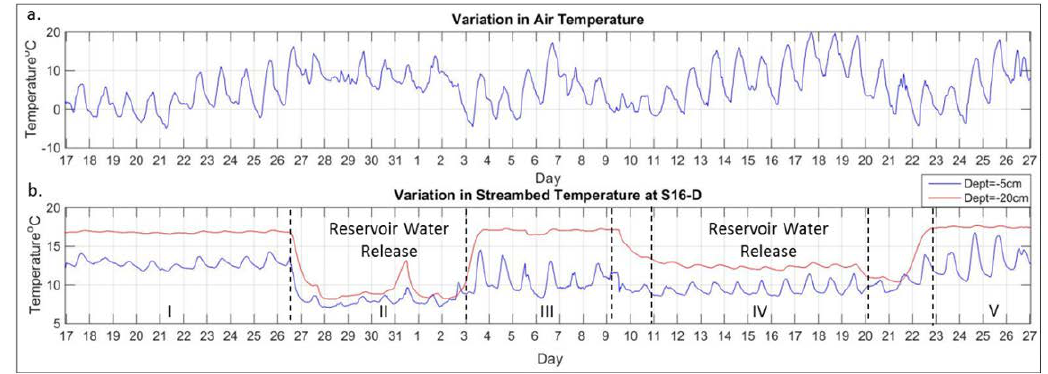
Figure 8. ( a ) Variation in air temperature; ( b ) variation in streambed temperature during March–April period at two different depths at site S16-D. Note that the measurement period is divided into five segments based on reservoir water